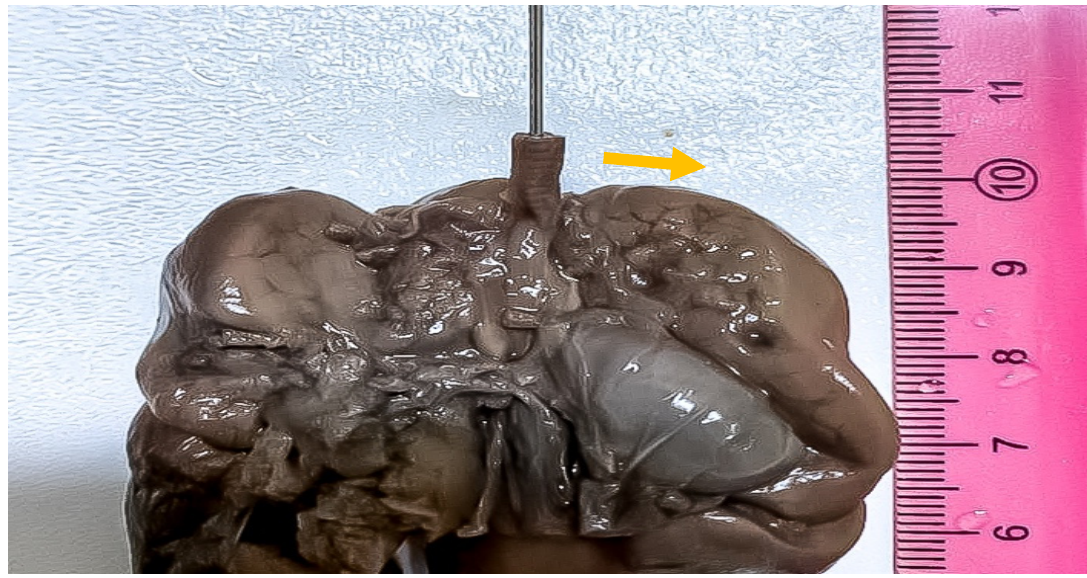
Figure 5. Gross aspect of the dissected cardiothoracic autopsy specimen in anterior view, showing imperforation level of the tracheal lumen, before opening (arrow).